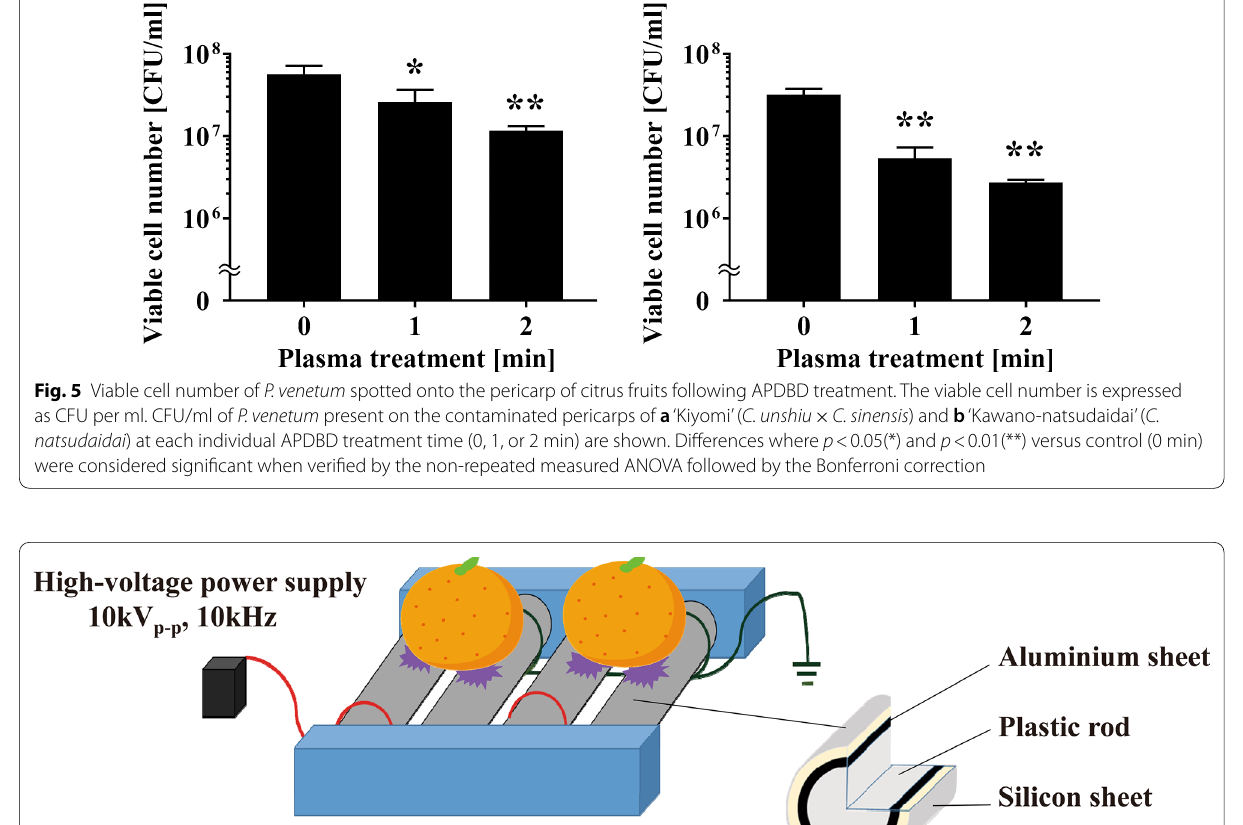
Fig. 6 Schematic representation of atmospheric pressure dielectric barrier discharge (APDBD) treatment of the surface of citrus fruits. APDBD treatment was performed using a roller conveyor plasma instrument. The plasma device comprised high-voltage electrodes and earth electrodes, both of which were composed of a plastic rod covered with an aluminium sheet and silicon sheet (0.5 mm thick). A high-voltage power supply [10 kV peak to peak (kV p–p ), 10 kHz] was used for plasma generation. Plasma treatment of the citrus fruit was performed with both electrodes attached to a high-voltage electrode and an earth